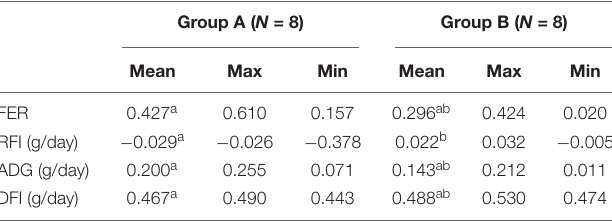
TABLE 1 | Phenotype statistics of two groups of abalone after a 72-day culture experiment.